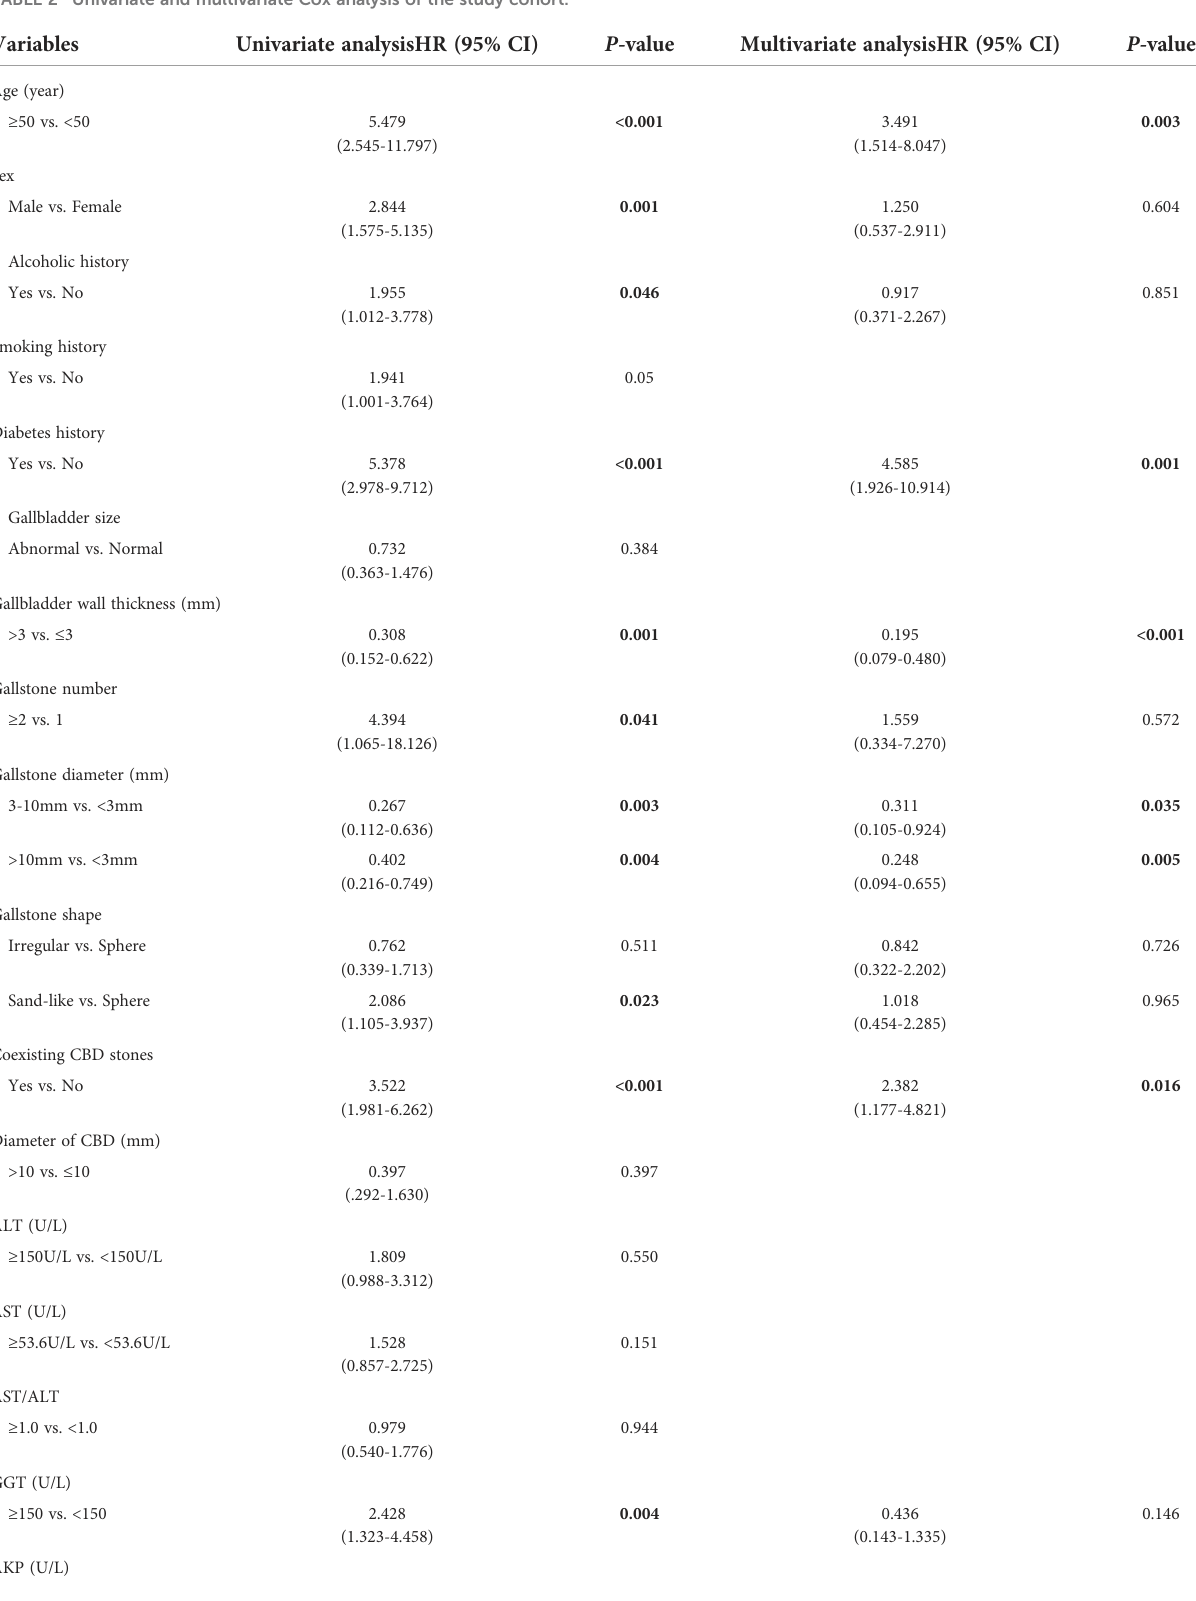
TABLE 2 Univariate and multivariate Cox analysis of the study